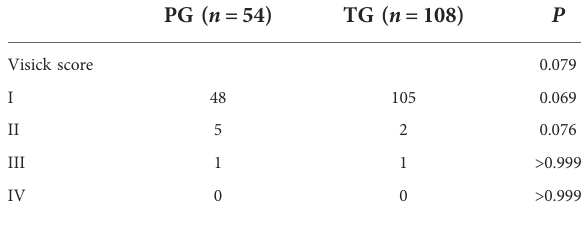
TABLE 6 Re fl ux symptom scores 1 year after surgery in the propensity score-matched patients who underwent proximal or total